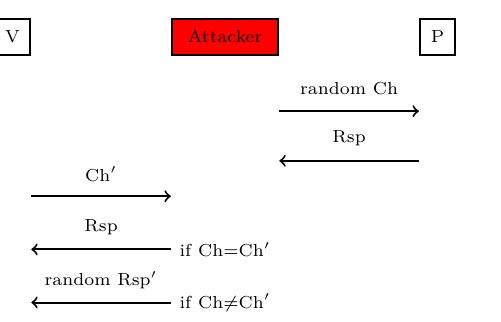
Figure 8: Pre-ask strategy in a relay attack.